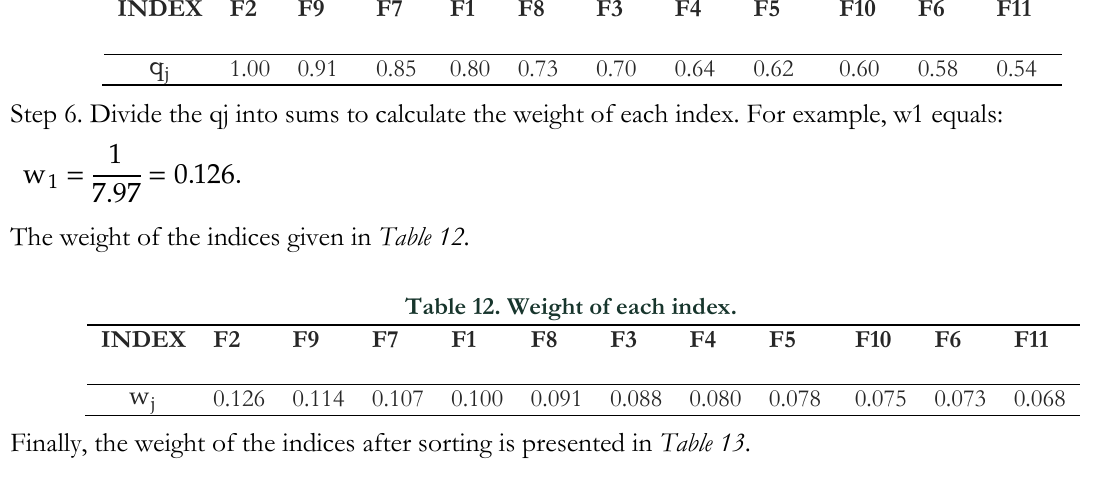
for each index. 𝐣